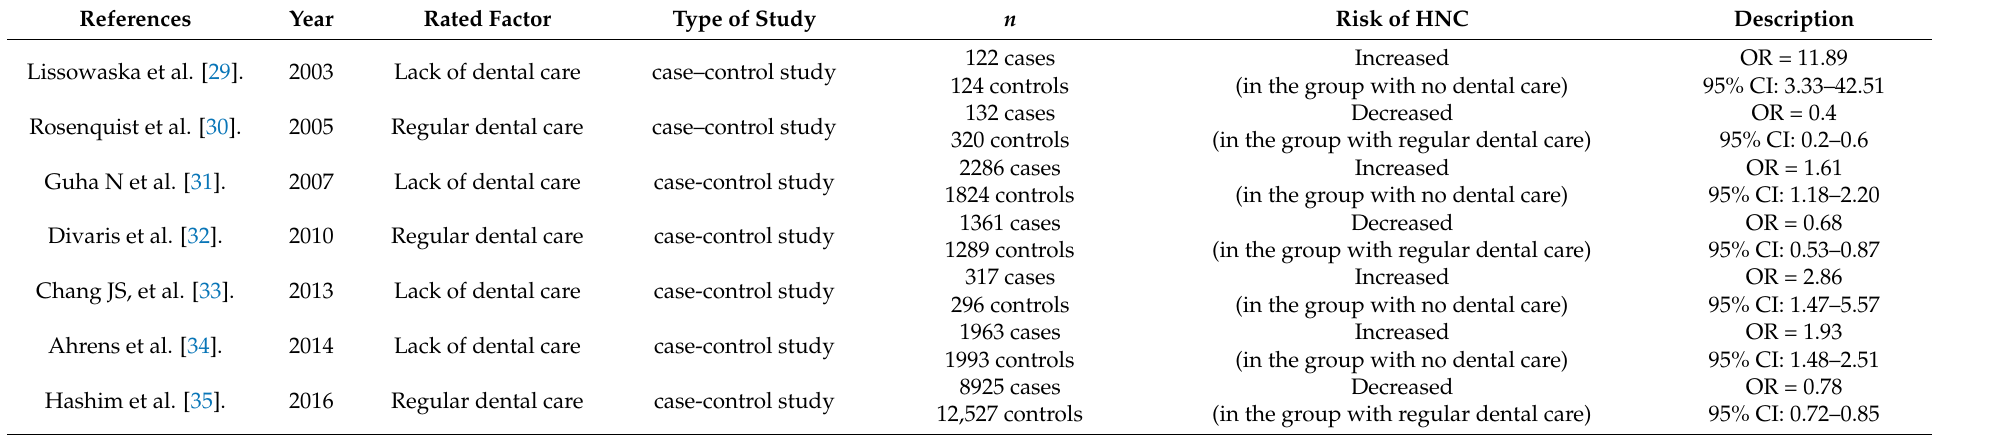
Table 1. The impact of regular dental visits on the risk of developing head and neck squamous cell carcinoma.